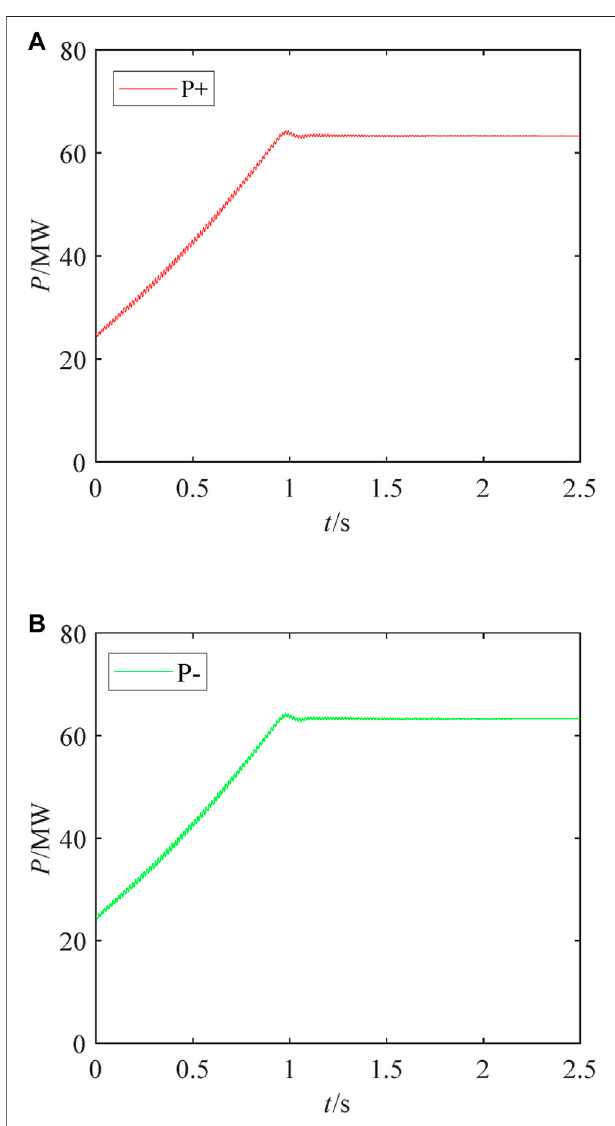
FIGURE 7 | Instantaneous power of abnormal grounding in the bipolar identical position.